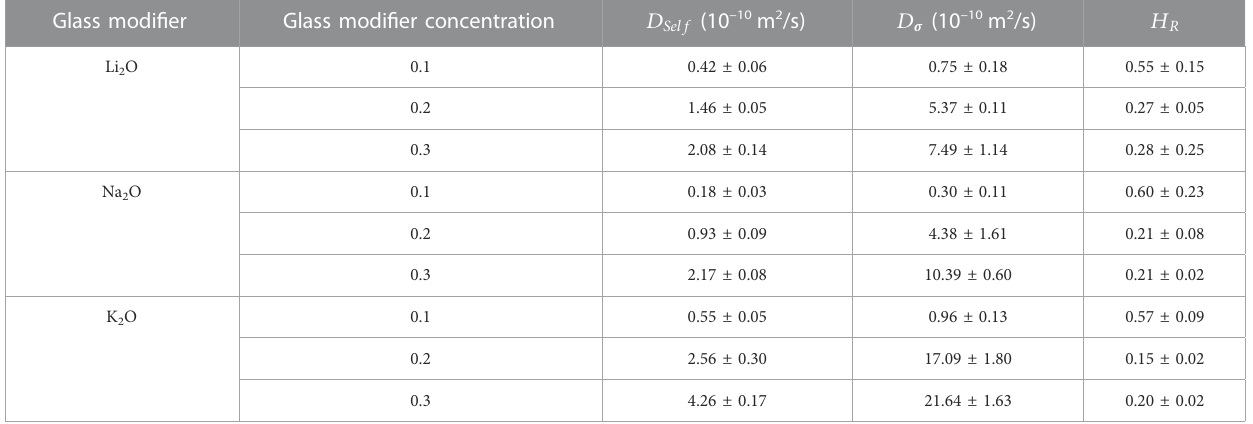
TABLE 3 Values for D Self and D σ obtained using linear fi ts from r 2 results and Eq. 3 for measurements determined at 1000 K. The errors were obtained by the standard deviation of three different results for D self and three different results for D σ from different MD experiments. Glass modi fi er Glass modi fi er